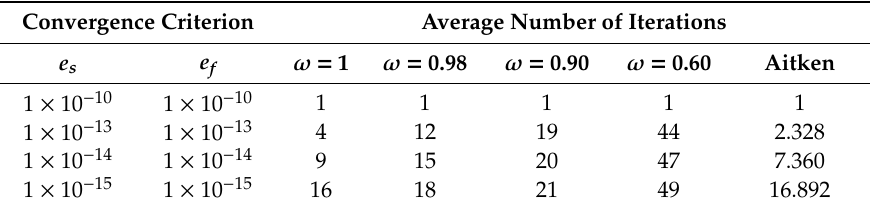
Table 5. Convergence comparisons of relaxation.